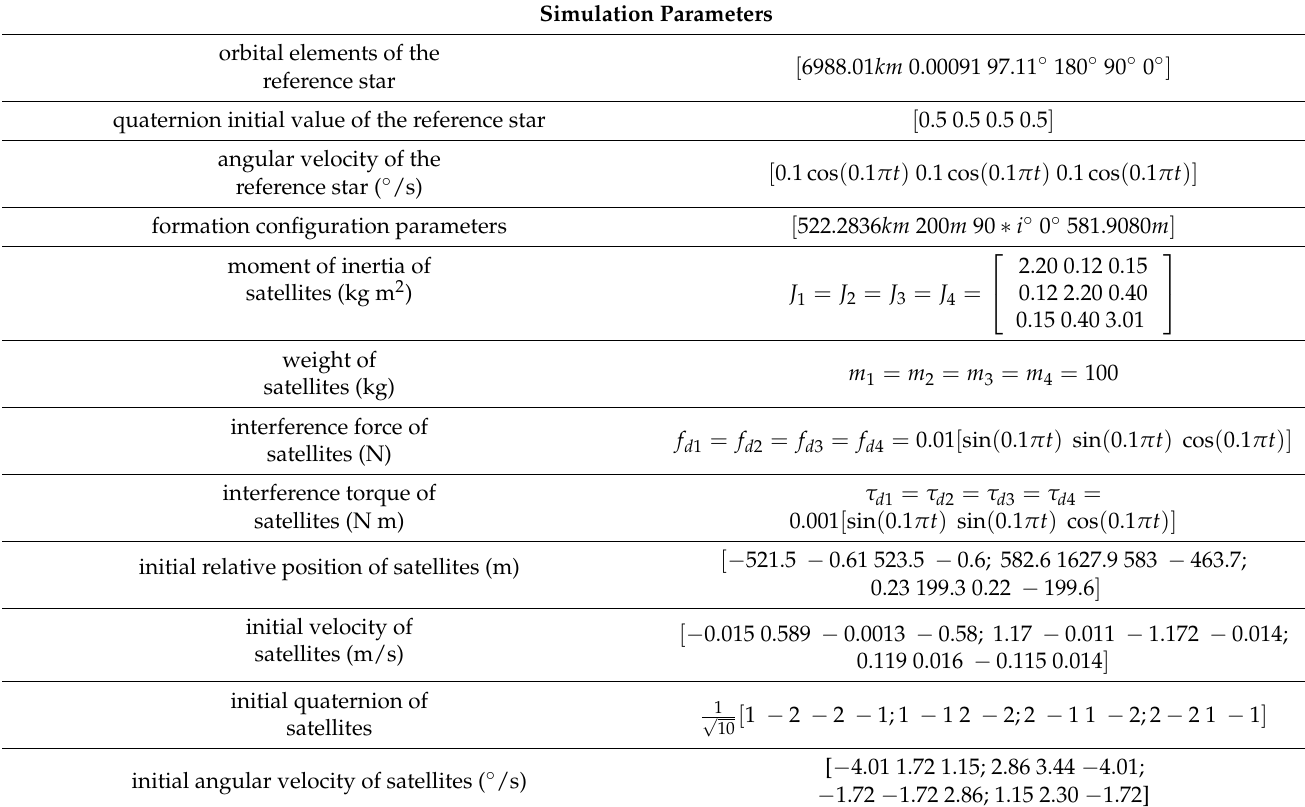
Table 1. SAR formation simulation parameters. Simulation